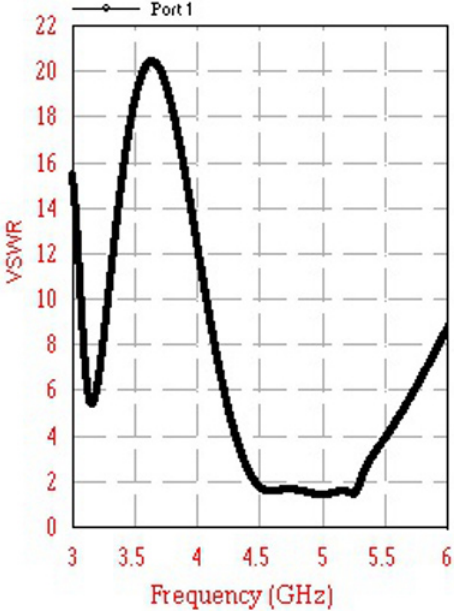
Figure 4. VSWR Vs frequency of slotted microstrip antenna.